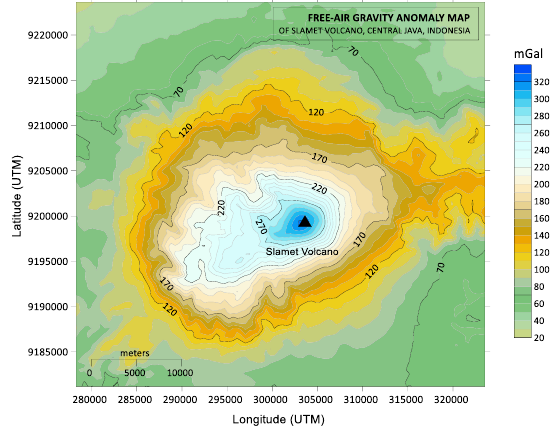
Fig. 5. The gravity disturbance contour map of study area To obtain the complete Bouguer anomalies (CBA) data, the Bouguer and terrain corrections have been applied to the gravity disturbance data. The Bouguer correction was used to eliminate the mass effect located between the measurement points on the topographic surface to the datum, which was not taken into account even though this mass greatly affected the gravity anomaly data [32]. Meanwhile, the purpose of terrain correction was to eliminate the mass influence around the measurement point. The terrain correction arose due to the change of the topography on the gravitational field at the measurement point. The terrain correction has been calculated